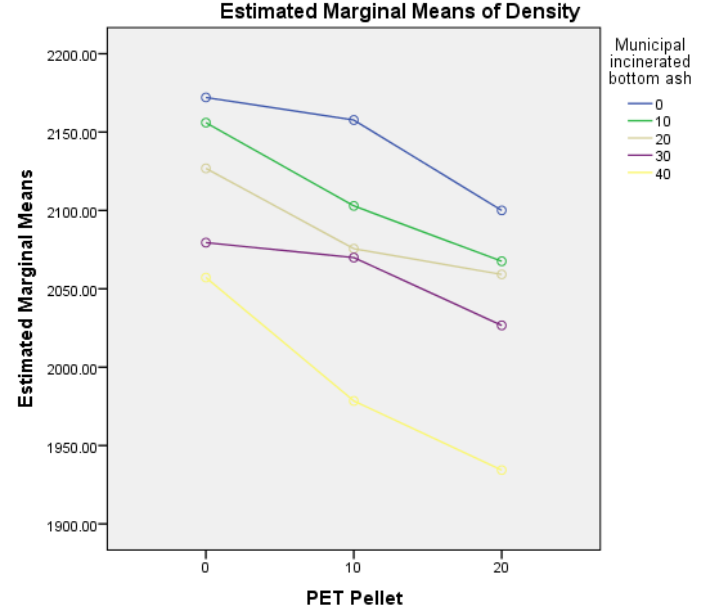
Figure 11. Estimated marginal means of density between PET pellets and MIBA.